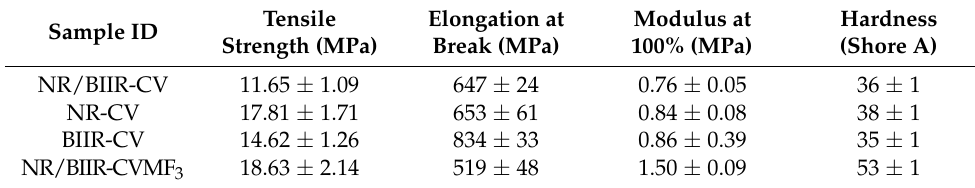
Table 3. Tensile properties and